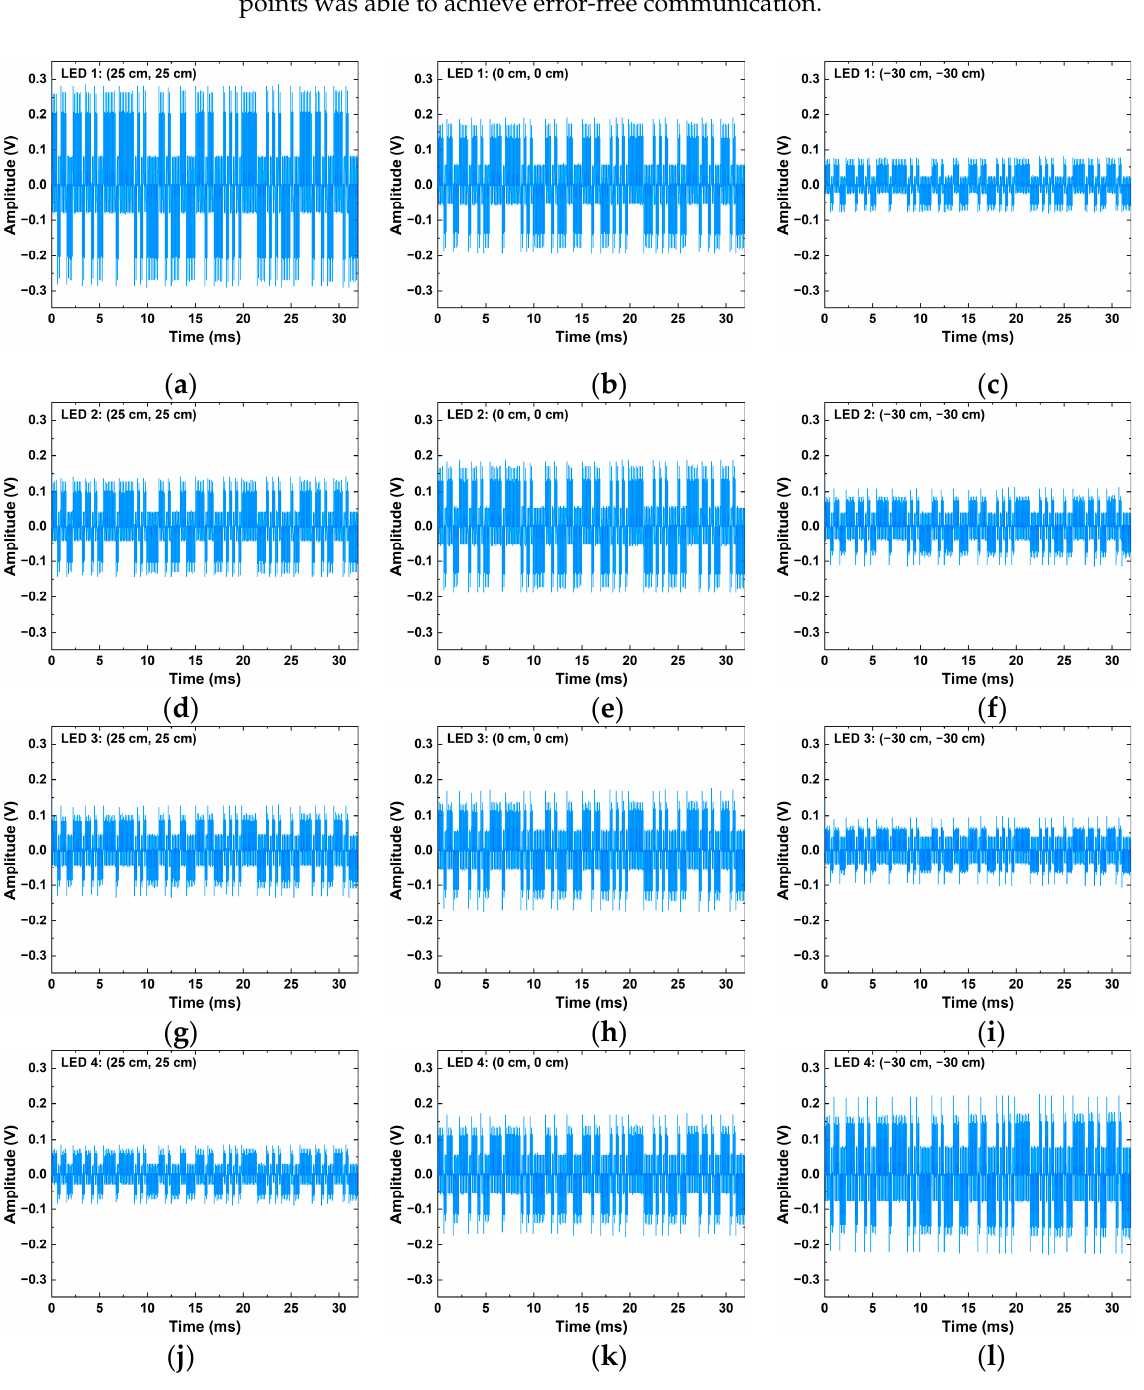
Figure 10. Frames of received waveforms of LED 1 ( a ) measured at point A, ( b ) measured at point B, and ( c ) measured at point C after sampling; frames of received waveforms of LED 2 ( d ) measured at point A, ( e ) measured at point B, and ( f ) measured at point C after sampling; frames of received waveforms of LED 3 ( g ) measured at point A, ( h ) measured at point B, and ( i ) measured at point C after sampling; and frames of received waveforms of LED 4 ( j ) measured at point A, ( k ) measured at point B, and ( l ) measured at point C after sampling.